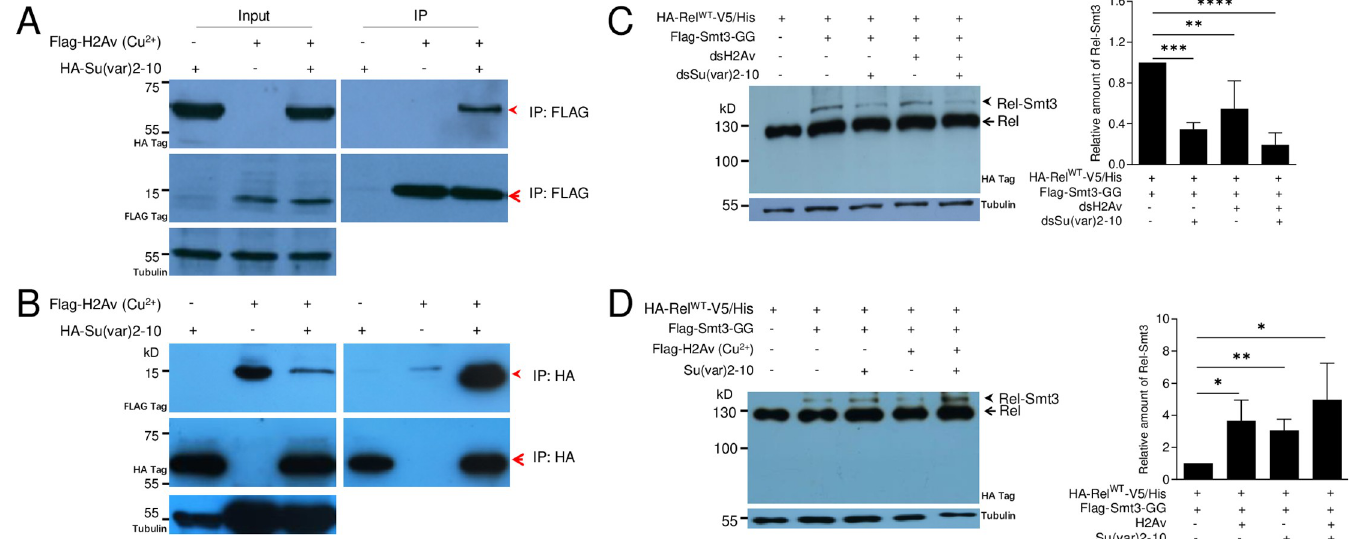
Fig 6. H2Av regulates Relish SUMOylation by interacting with Su(var)2-10. (A, B) Physical interaction between H2Av and Su(var)2-10. Flag-H2Av and/or HA-Su (var)2-10 were expressed in S2 cells using the Cu 2+ -inducible pMT/Bip/V5-His vector. Either antibody against Flag-H2Av (A) or against HA-Su(var)2-10 (B) was used for immunoprecipitation. (C) Knockdown of H2Av and Su(var)2-10 separately or together decreases the amount of SUMOylated Relish (Rel-Smt3). Western blot (Left) shows the change of SUMOylated Relish (Rel-Smt3) after RNAi. Rel-Smt3 was quantified (Right). Rel-Smt3 produced when Rel WT and Smt3 were co-expressed is equal to 1. Data represent the average of at least three independent assays (mean ± SE). (D) Over-expression of H2Av and Su(var)2-10 separately or together significantly increases the amount of SUMOylated Relish (Rel-Smt3). Western blot (Left) shows the change of SUMOylated Relish (Rel-Smt3) after over-expressing H2Av and/or Su (var)2-10. Rel-Smt3 was quantified (Right). Rel-Smt3 produced when Rel WT and Smt3 were co-expressed is equal to 1. Data represent the average of at least three independent assays (mean ± SE). One way ANOVA with Tukey’s multiple comparisons test was performed. � p < 0.05, �� p < 0.01, ��� p < 0.001, and ���� p <